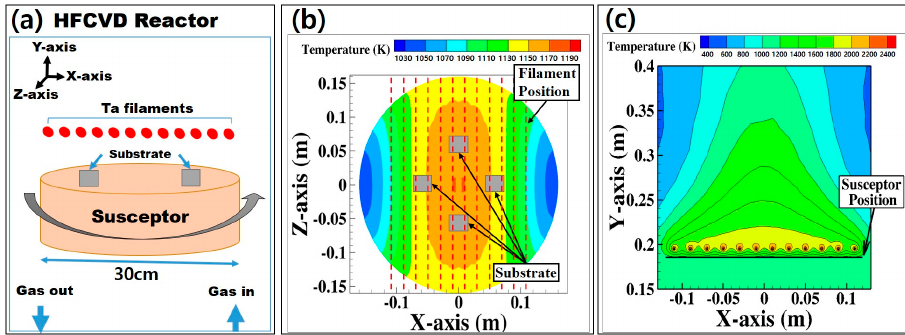
Figure 1. ( a ) Schematic of a hot filament chemical vapor deposition (HFCVD) reactor and temperature distributions on ( b ) the horizontal planes and ( c ) the vertical planes.